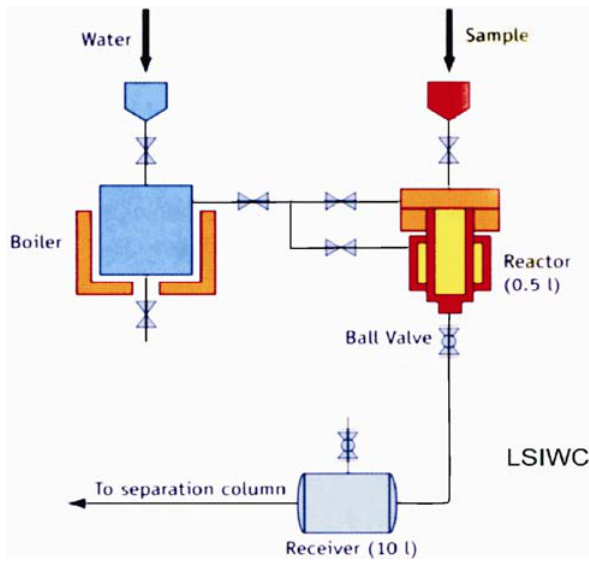
Fig. 1. Diagram of the experimental SE unit